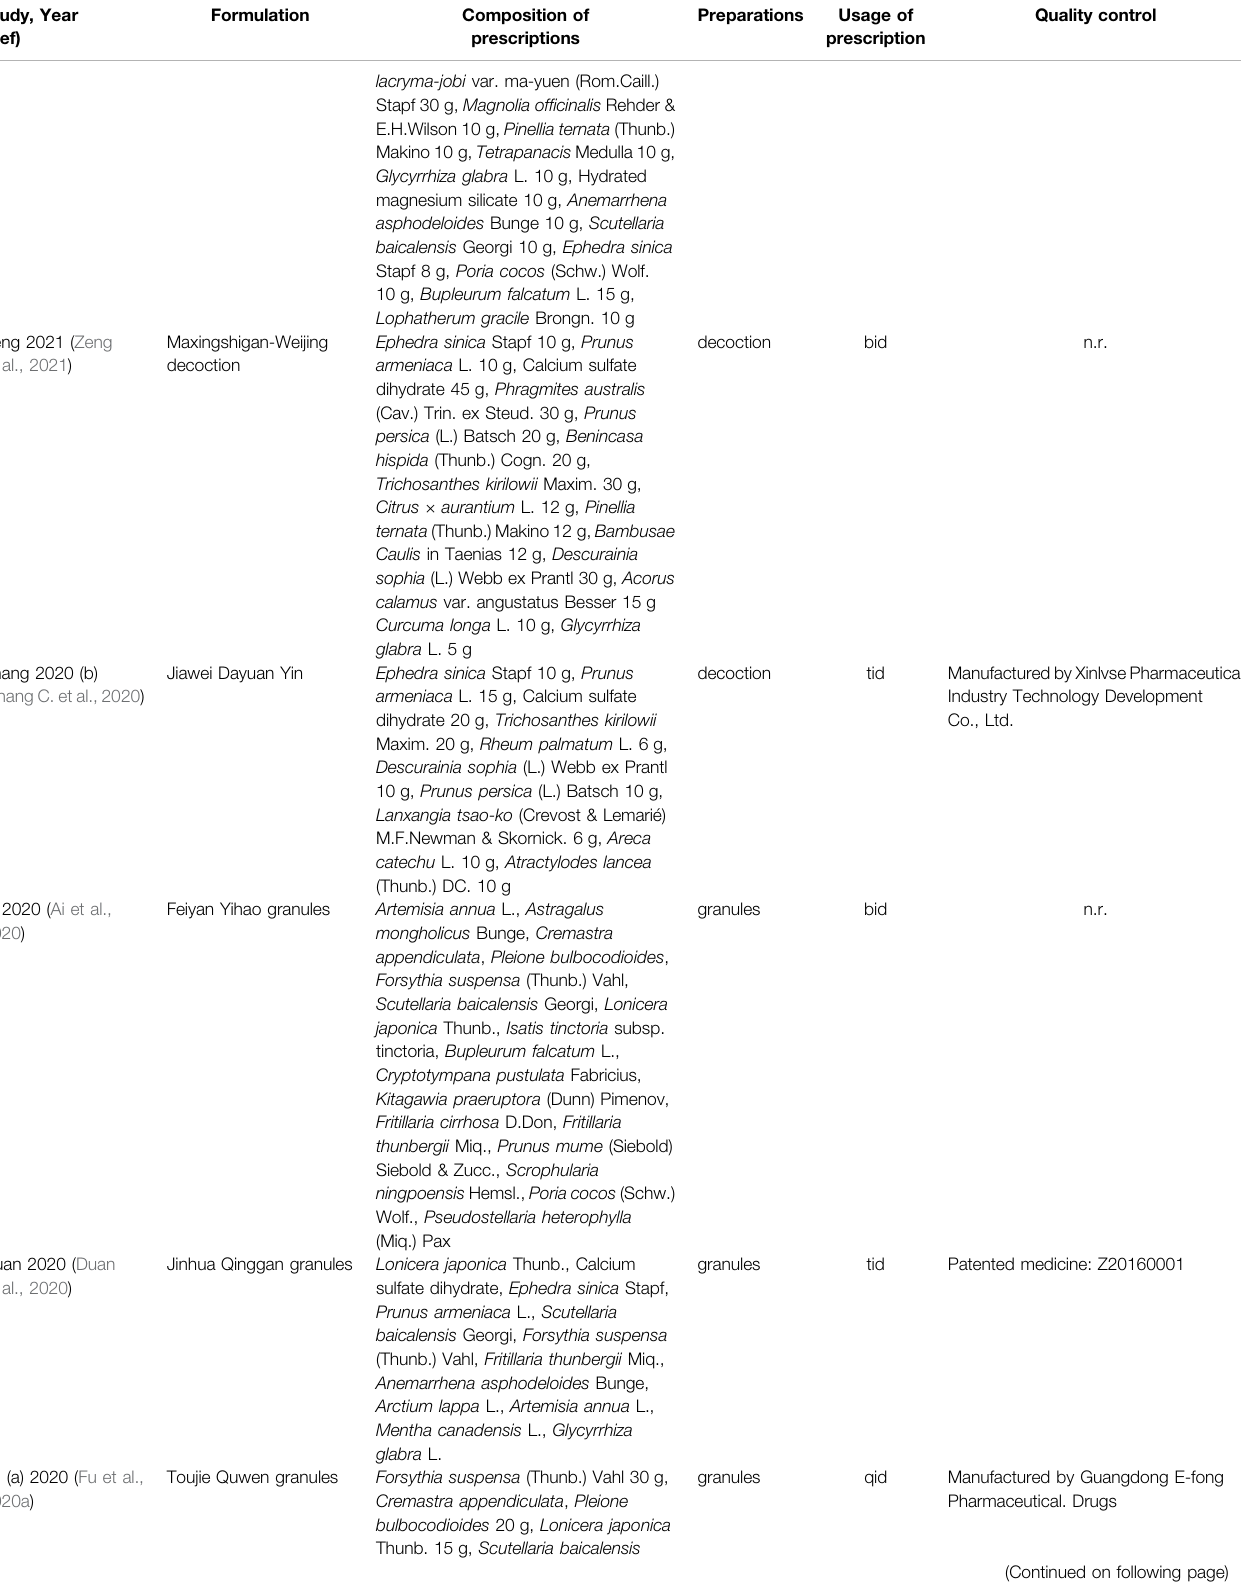
TABLE 2 | ( Continued ) Compositions and usage of herbal medicine for the treatment of